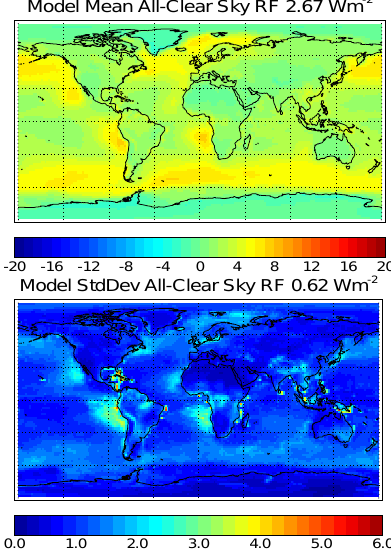
Fig. 17. Annual multi-model mean and standard deviation dif- ference between all-sky and clear-sky top-of-atmosphere radia- tive forcing between experiments FIX2 and FIX0 with AOD=0.2 and AOD=0.0 distributed over the lowest two kilometers, hold- ing SSA=1.0 and ANG=1.0 constant. Model fields have been remapped to a resolution of 1.875 ◦ × 1.875 ◦ .